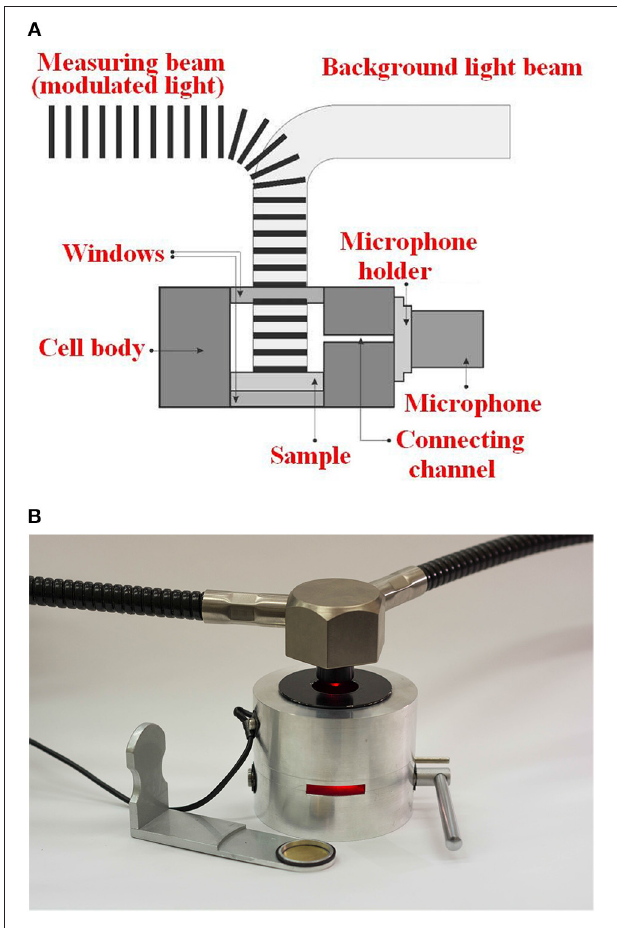
FIGURE 5 | (A) Schematic diagram of PA system. (B) Laboratory-built closed-type photoacoustic